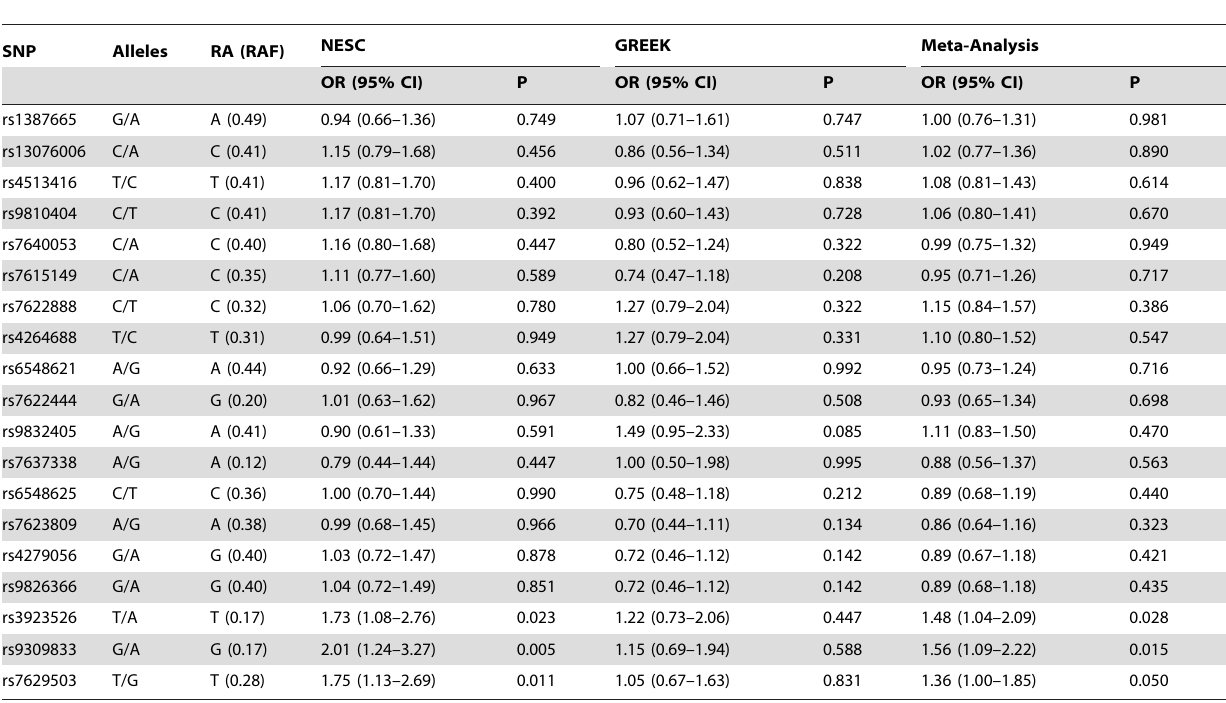
Table 3. Association results of ROBO1 SNPs for dry AMD in the NESC and GREEK cohorts, and in meta-analysis using an additive model.